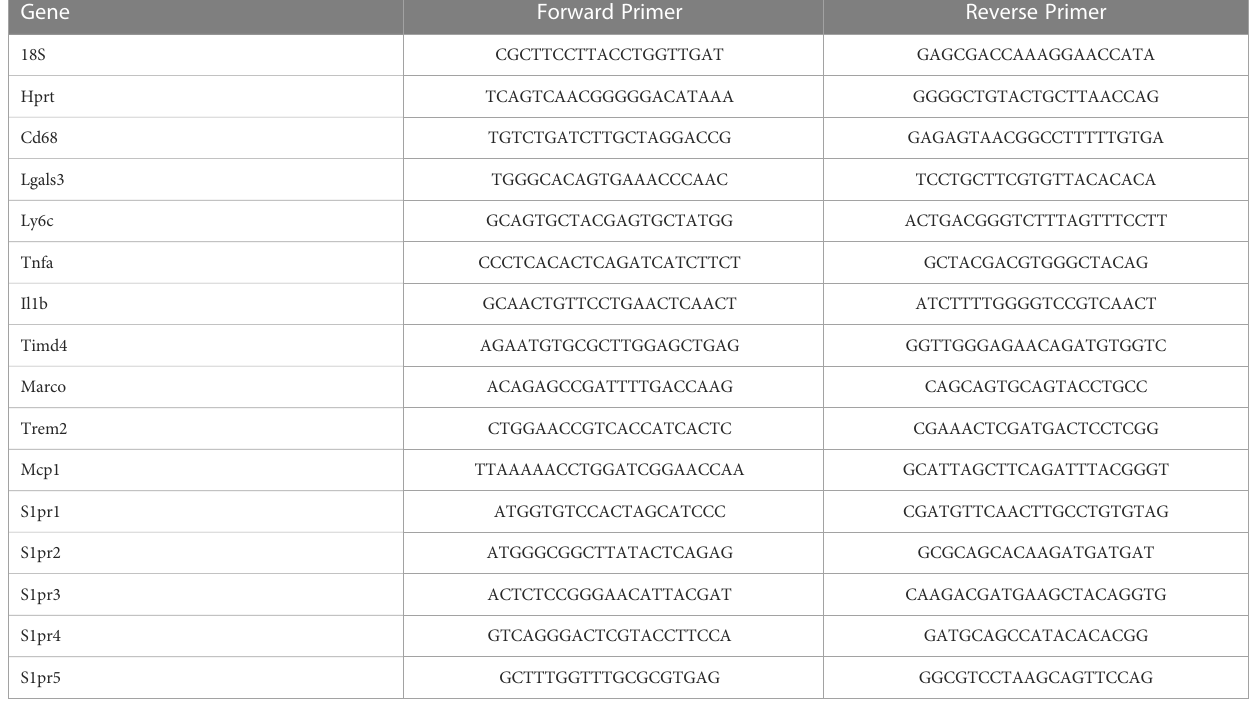
TABLE 1 Mouse qPCR